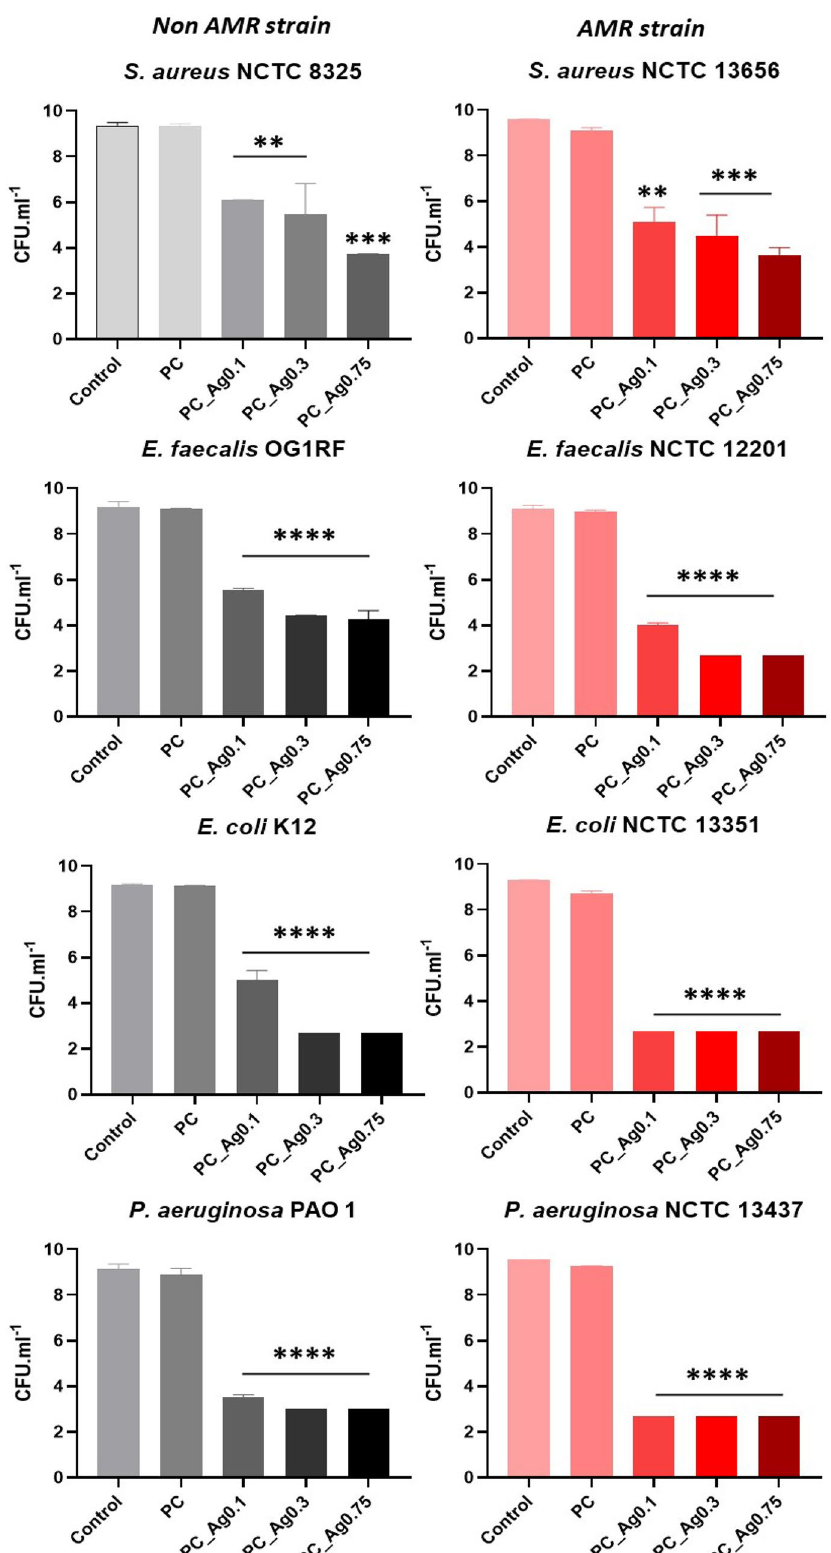
Figure 5. Antibacterial activity of PC gels against non-AMR and AMR bacterial strains of S. aureus , E. faecalis , E. coli and P. aeruginosa . Bacterial reduction is expressed as the mean of CFU/mL ± standard deviation (error bars). Statistical analysis was performed using two-way ANOVA (** p ≤ 0.01; *** p ≤ 0.001; **** p ≤ 0.0001). Asterisks illustrate the degree of statistical difference of the samples when compared to the